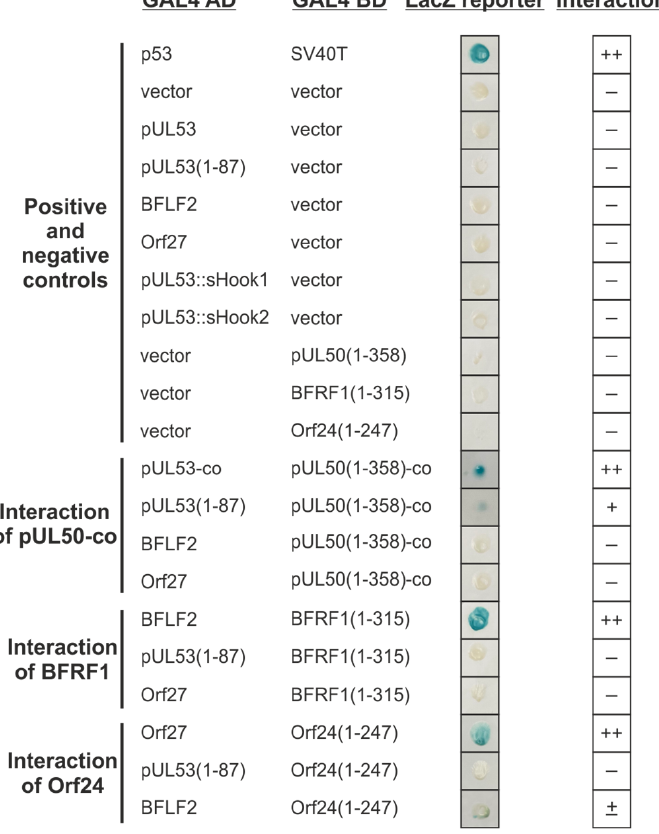
Figure 5. Y2H analysis of interactions between the hook and groove proteins of HCMV, EBV and VZV. The indicated hook proteins fused to the GAL4 AD, were cotransformed in various combinations with groove proteins fused to the GAL4 BD, into yeast strain Y153. The ß-galactosidase expression was detected with the filter lift assay. The known interaction of cellular tumor suppressor p53 with the simian virus 40 (SV40)-derived oncoprotein SV40T served as a positive control. The cotransformation of the empty vectors pGAD424 and pGBT9 with the constructs were used as a negative control. Interaction analysis of codon-optimized pUL50-co, BFRF1 and Orf24 with codon-optimized pUL53- co, pUL53(1–87), BFLF2 and Orf27, respectively. ++, indicates ≥ 50%; +, indicates < 50% Xgal-positive yeast colonies in the filter lift assay measuring interaction; –, indicates not interacting protein